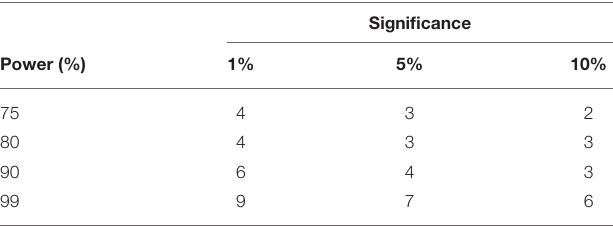
TABLE 3 | Sample size based on usual approach to identify difference between CV of PRE and ONLINE blocks of PEI treatment.